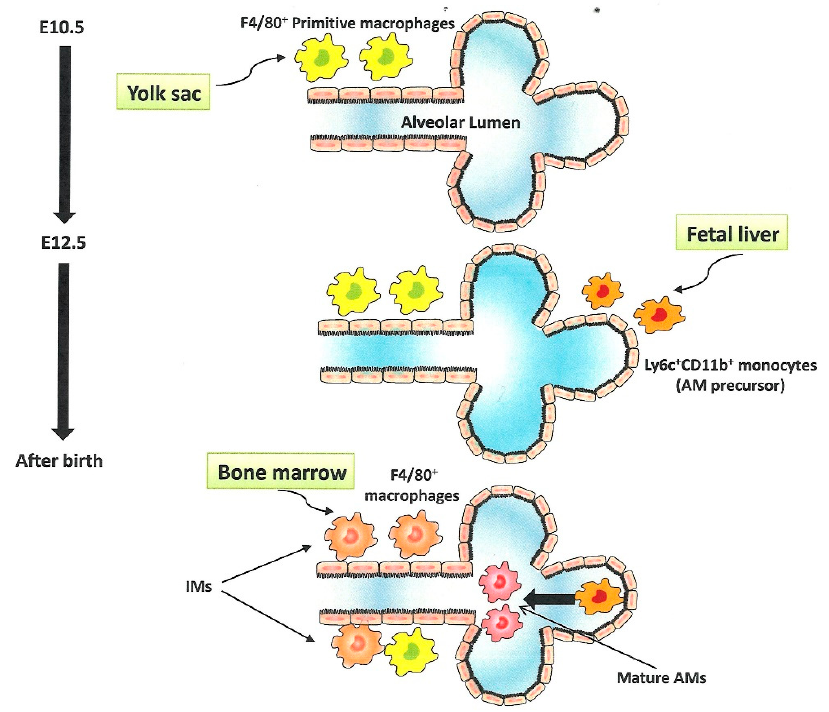
Figure 2. Ontogeny of alveolar macrophages (AMs) and interstitial macrophages (IMs). Beginning at embryonic day (E) 10.5, yolk sac-derived primitive macrophages migrate into lung parenchyma. Beginning at E 12.5, fetal liver-derived monocytes migrate into lung parenchyma and persist as AM precursors. After birth, AM precursors migrate into alveolar lumen and differentiate into mature AMs under the guidance of GM-CSF. Concurrently, bone marrow-derived macrophages migrate into parenchyma to replace some of the yolk sac-derived primitive macrophages and differentiate into IMs. Persistent yolk sac-derived macrophages also differentiate into IMs.